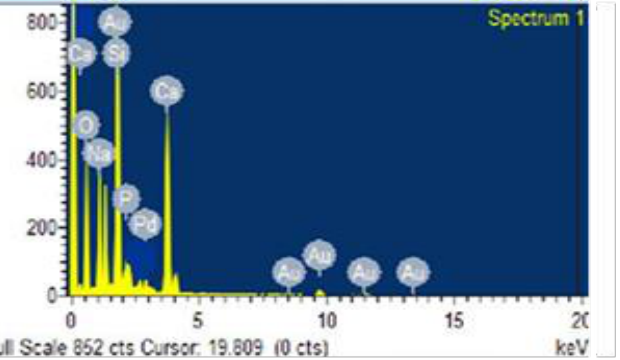
Figure 6. EDS spectrum of bioglass